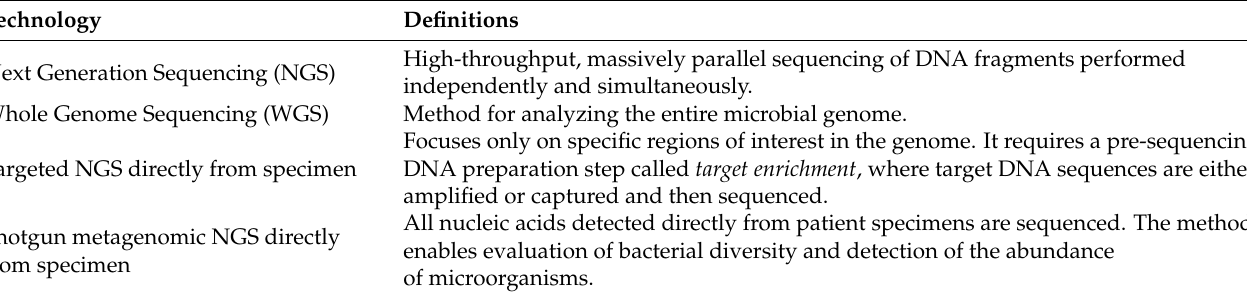
Table 3. Terms used in the area of Next Generation